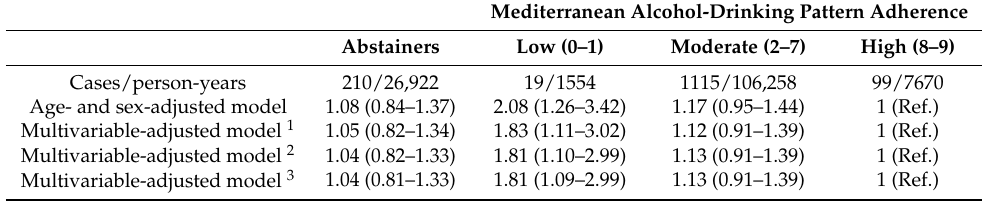
Table 2. Association between adherence to the MADP and HT